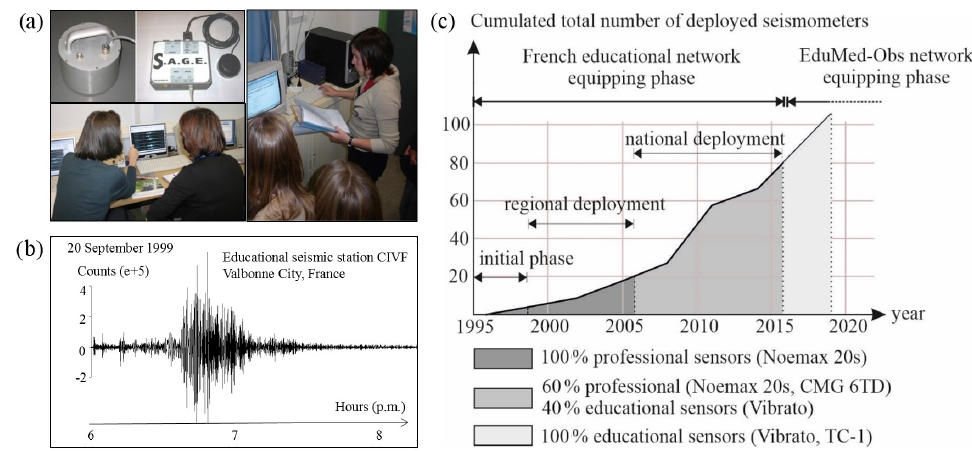
Figure 1. First educational seismic stations deployed at the International Campus of Valbonne (CIV). (a) Students working on seismograms from a specific educational database. Informed consent was provided by the individuals pictured for the publication of these identifiable images. (b) Record of the Chi-Chi earthquake (Taiwan, M w 7.6), which occurred on 20 September 1999 and was recorded at the French educational CIVF seismic station. Values in abscissa are the after-noon hours of the current day (universal coordinated time – UTC). (c) Evo- lution of the number of educational seismometers deployed during from the past (equipping phase of the French educational network) to the present with the EduMed-Obs project. Colors under the curve and corresponding colored boxes give an indication of the kind of sensors deployed during each phase. (See the data availability section at the end of the paper for further